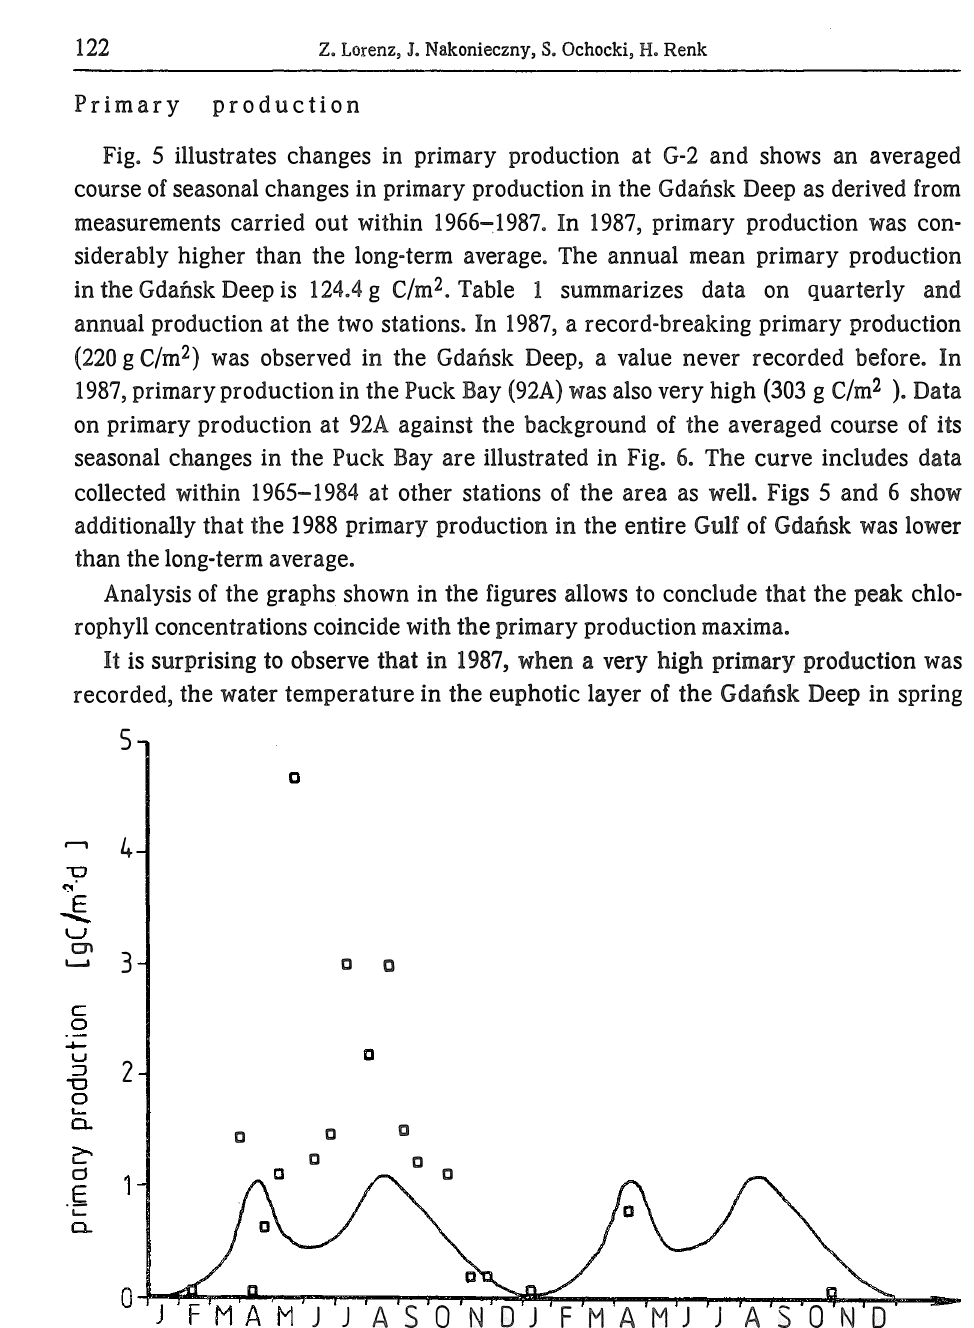
J ASONOJ FMAMJ J ASOND month· Fig, 6. Seasonal changes of primary production at 92A (Puck Bay) in 1987-1988 compared with long·term